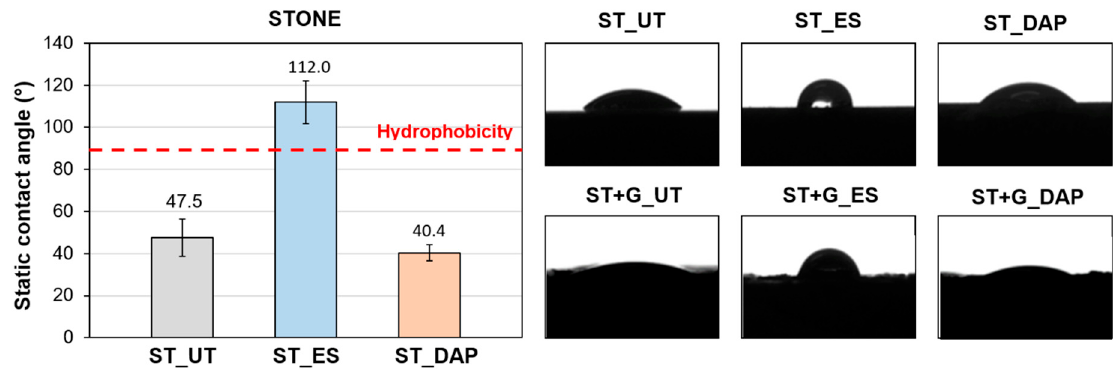
Figure 12. Values of static contact angle of untreated (“UT”) and treated (“ES” and “DAP”) stone specimens (“ST”) and photos of the static contact angle of both “ST” and “ST+G” specimens.